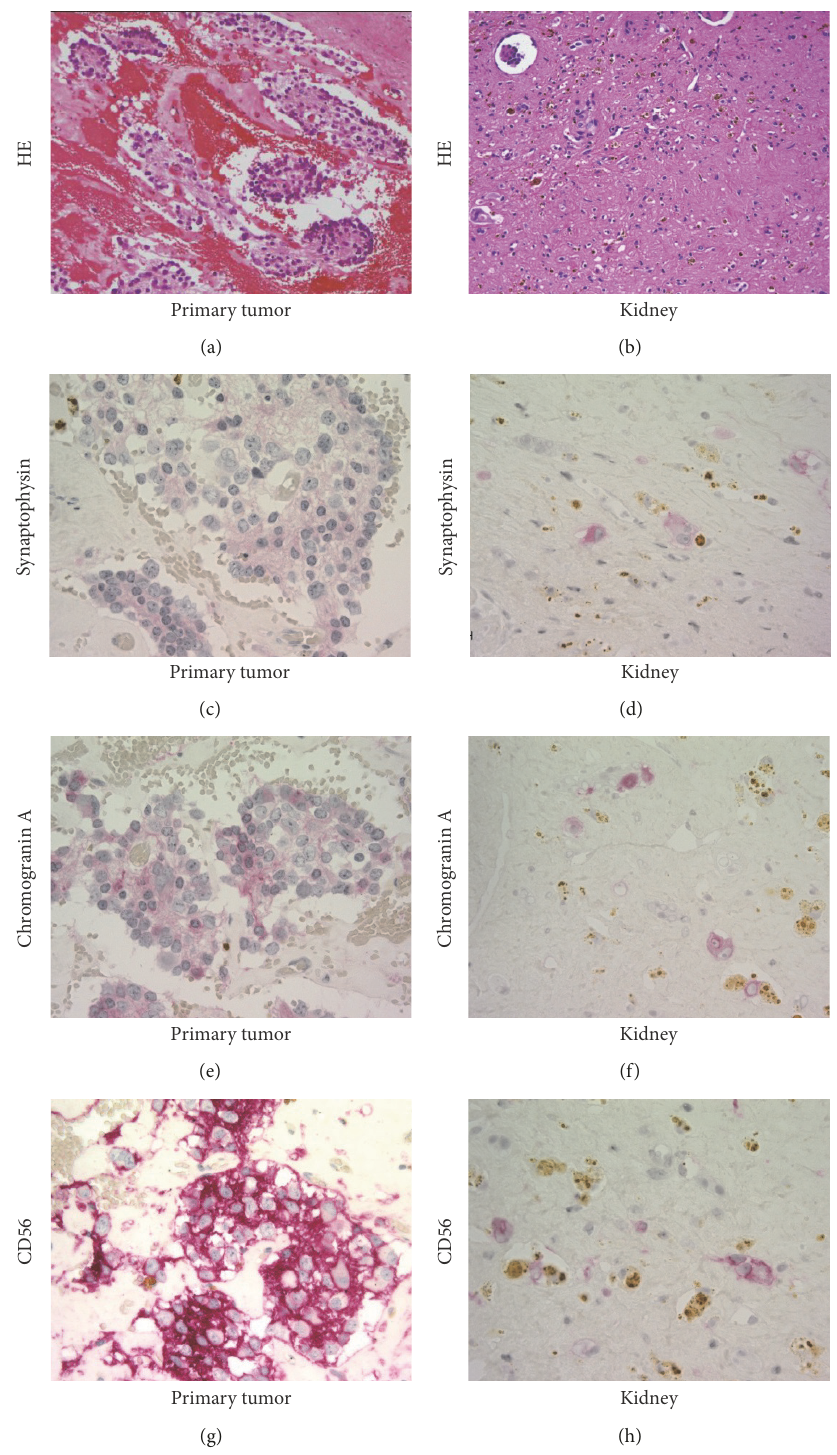
Figure 2: Histological findings of the primary tumor and a residual mass in the left kidney. In the primary tumor, H&E staining demonstrated neuroblastoma cell clusters (a), and these cells were immunohistochemically positive for (c) synaptophysin, (e) chromogranin A, and (g) CD56. In the left kidney, it was difficult to identify the metastatic lesion due to chemotherapy (b); however, immunohistochemistry revealed the individually scattered neuroblastoma cells (d–h). Note that color reaction was performed using new fuchsin (red), and brown pigments were hemosiderin or